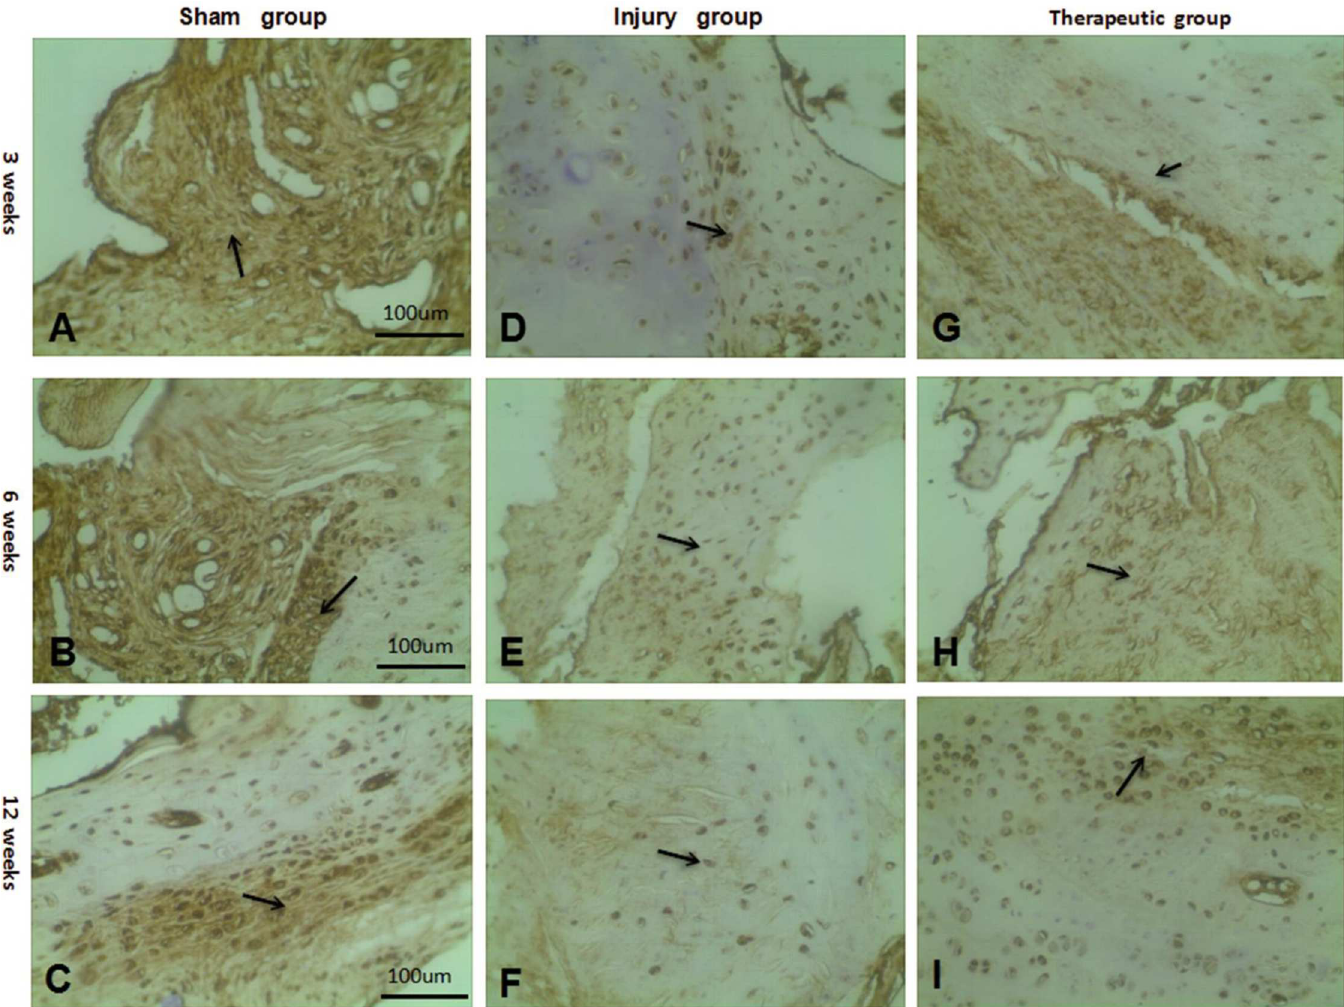
Fig 6. The results of type II collagen staining in each group after 3,6,12 weeks. (A-C) Type II collagenstaining in the sharm group after 3,6,12 weeks ( × 100).(D-F) Type II collagenstainingin the injury group after 3,6,12 weeks ( × 100). (G-I) Type II collagenstainingin the therapeuticgroupafter 3,6,12 weeks ( × 100).Black arrows: type II